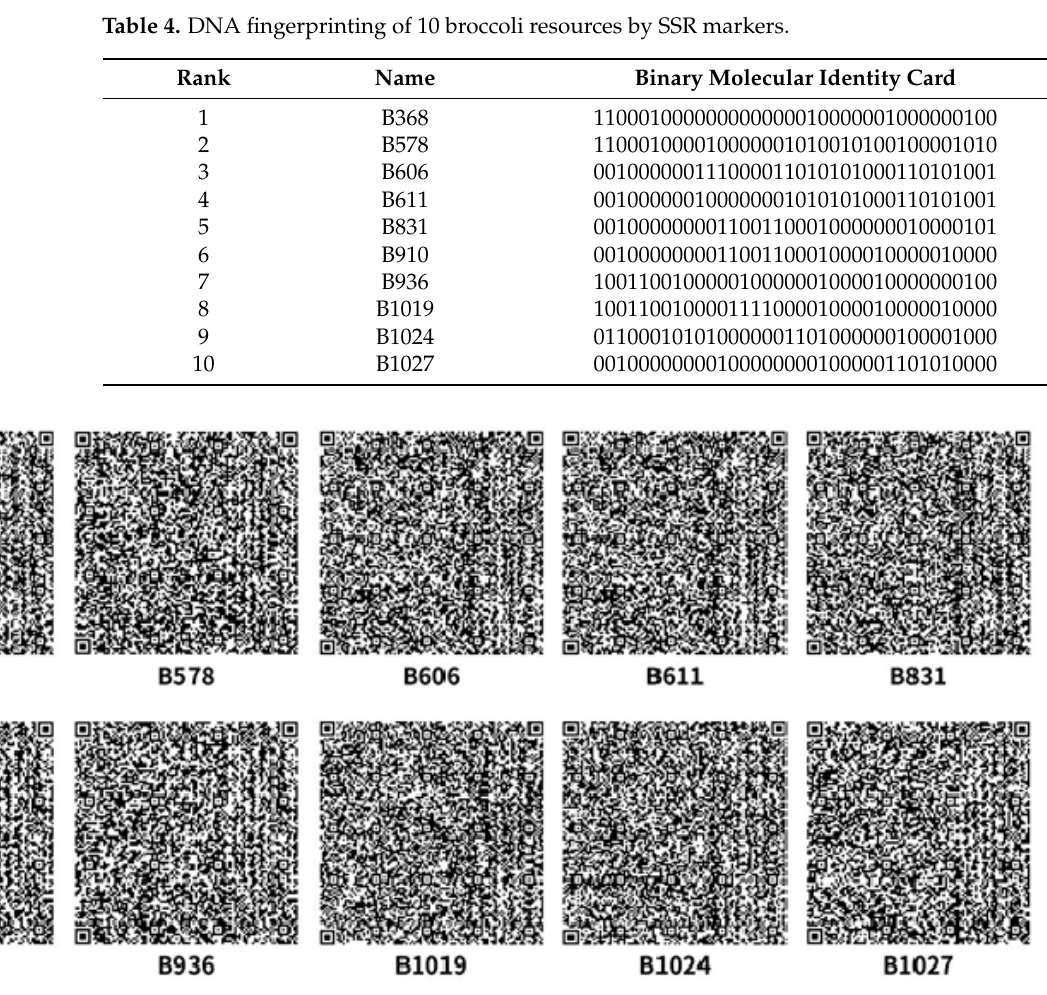
Figure 1. The PCR results of some SSR markers in 10 broccoli genotypes. M, D500 Marker, letters a